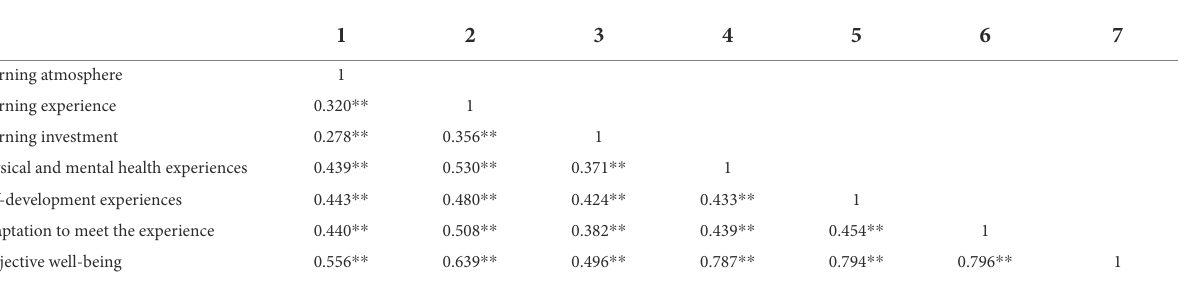
TABLE 4 Correlation between